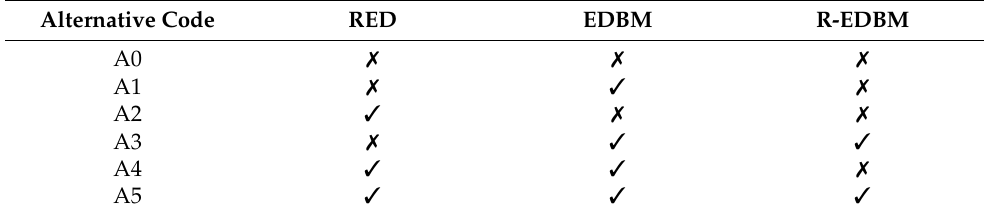
Table 3. Electro-membrane technologies employed for each